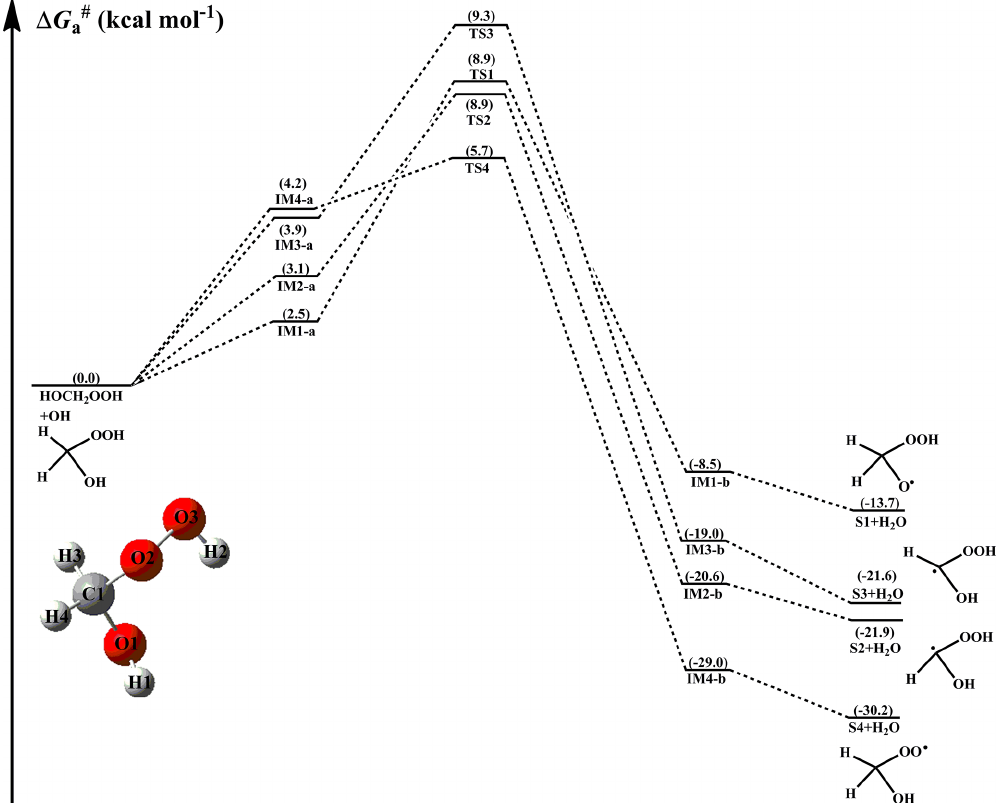
Figure 2. PES ( (cid:49)G # a ) for the OH-initiated reactions of HOCH 2 OOH from the CH 2 OO + H 2 O reaction predicted at the M06-2X/ma- TZVP//M06-2X/6-311+G(2df,2p) level of theory (a and b represent the pre-reactive and post-reactive complexes).